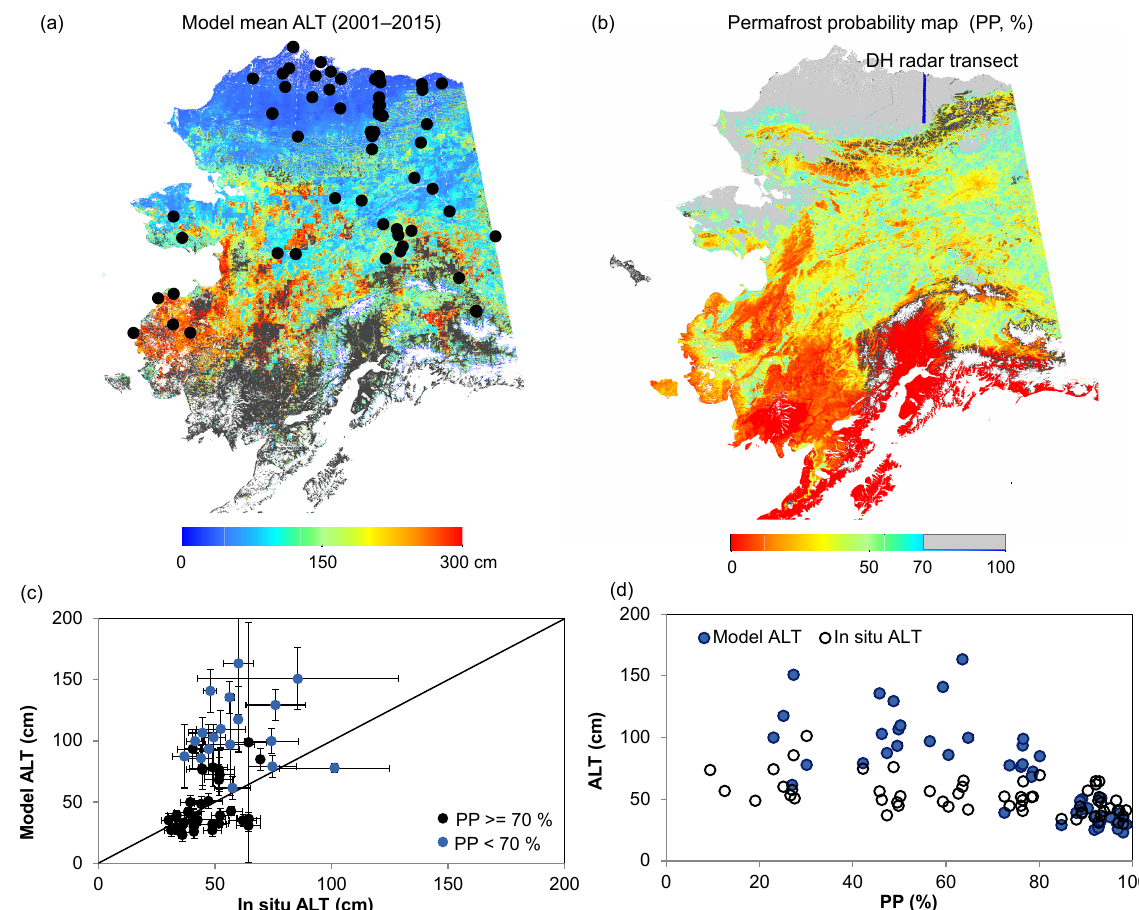
Figure 3. Model-simulated ALT and its performance against in situ CALM sites for different permafrost probability (PP) zones: (a) model- simulated 1km mean ALT map from 2001 to 2015; (b) a satellite-based permafrost probability map (Pastick et al., 2015); (c) comparisons of model-simulated ALT against in situ CALM sites for different PP zones; (d) the changes of model and in situ observed ALT with permafrost probability. The areas with ALT greater than 300cm depth are shown in dark gray (a) . In panel (b) , the areas with PP ≥ 70% are shown in gray, while areas outside of the PP classification are shown in black. The blue line in panel (b) indicates the location of the airborne DH radar flight transect used for model evaluation (Fig. 4). The error bars in (c) represent the standard deviation of either model-simulated or in situ observed ALT during the overlapping